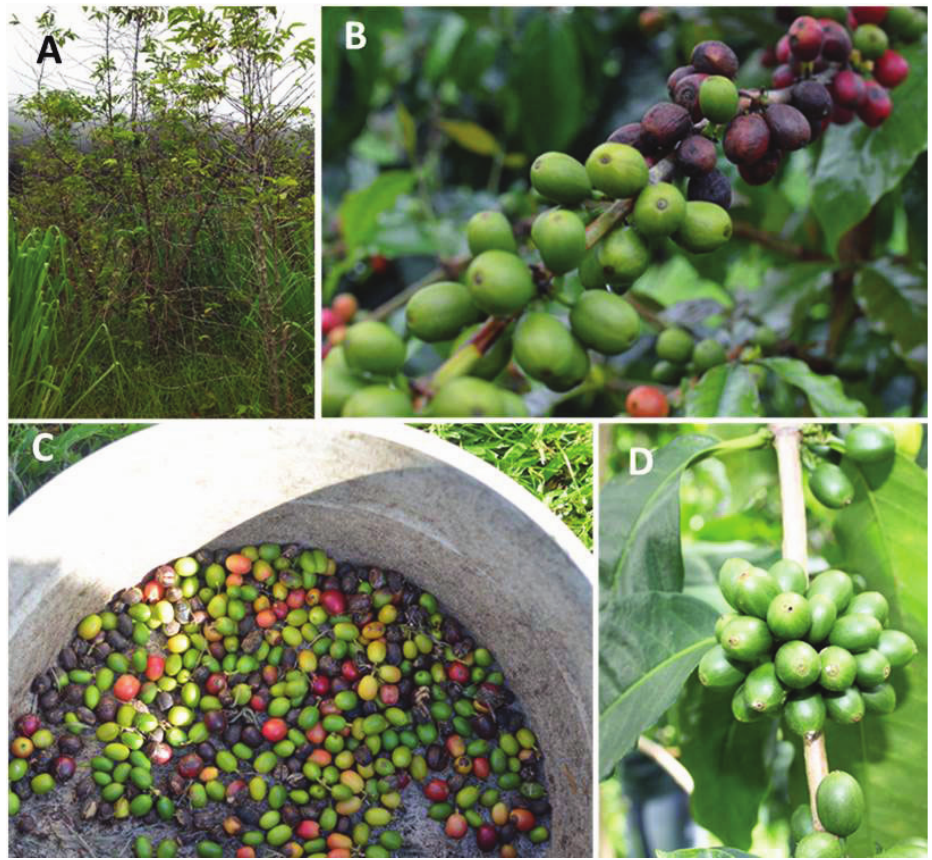
Figure 1. Feral coffee in Hawaii may allow the spread of CBB, ( A ); over-ripe and raisin berries are high source of CBB ( B ); berries collected from the ground helps control CBB ( C ); green berries attacked by CBB ( D ). Photos taken in Pahala, Hawaii by Libia C. Mahé, and Luis F.